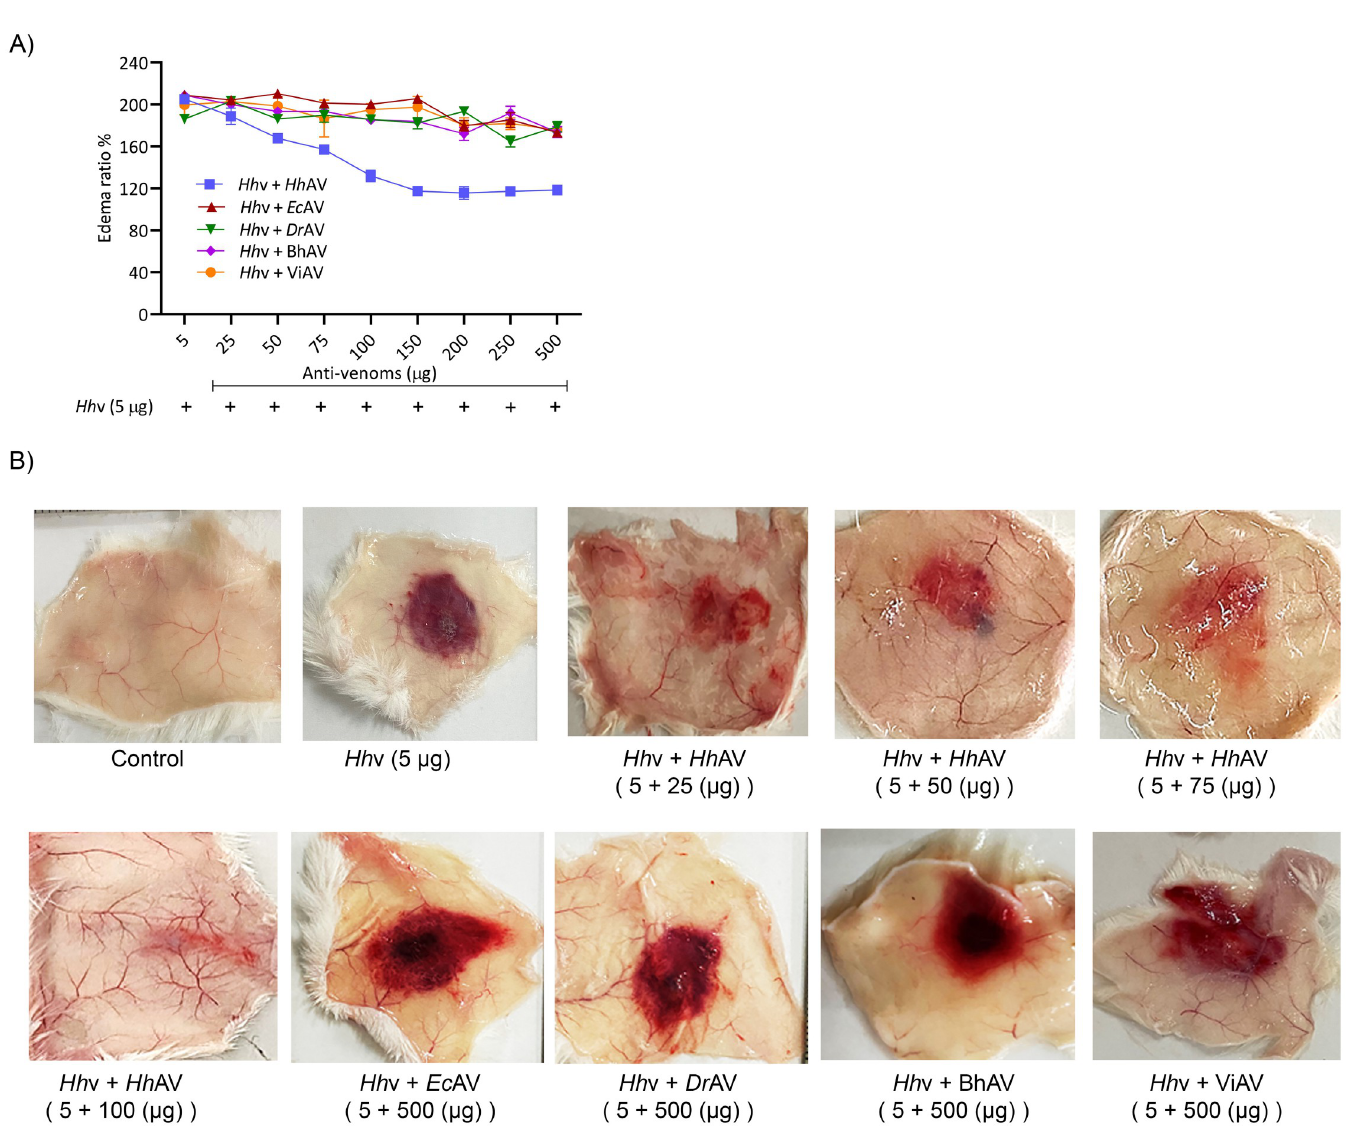
Fig 9. Neutralization of edema inducing activity and hemorrhagic activity of H . hypnale venom by anti-venoms using murine model. (A) Edema inducing activity, and (B) hemorrhagic activity of Hh v; in both cases, Hh v was independently pre-incubated with various doses (50–500 μ g) of Hh AV, Ec AV, Dr AV, BhAV, and ViAV for 15 min at room temperature. Hh v, 5 μ g alone was considered as 200% edema-inducing activity, and 5 μ g Hh v alone was considered as 100% hemorrhagic activity. The data is presented as Mean ± SEM (n = 3).